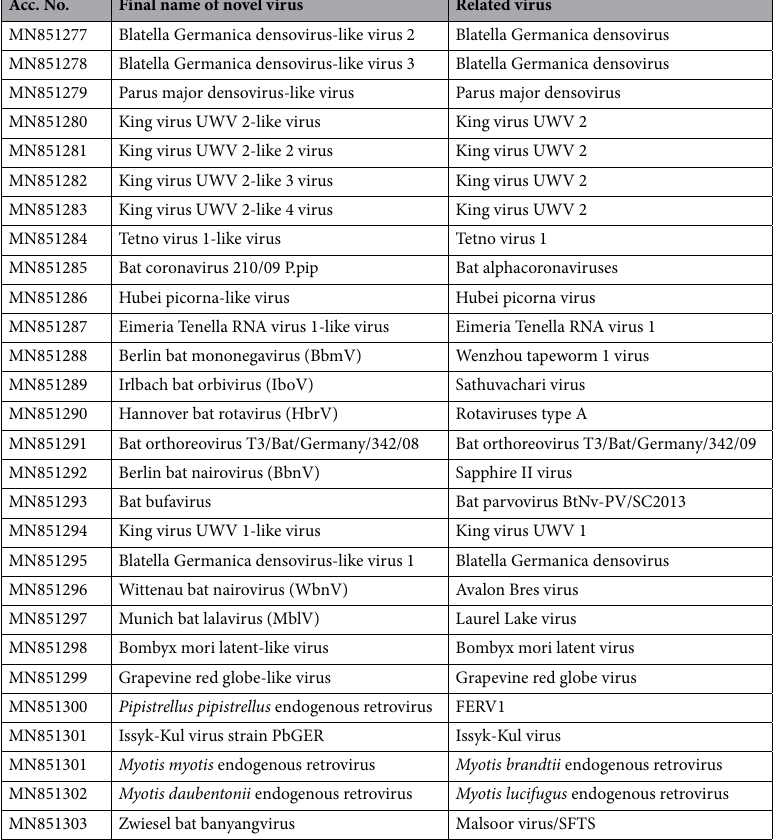
Table 4. Names and accession numbers of novel virus sequences.